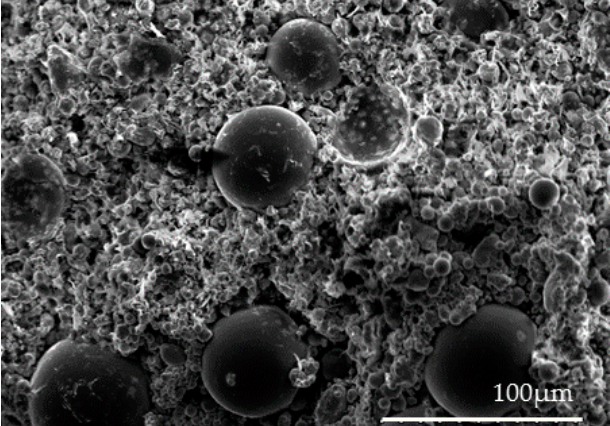
Figure 2. Scanning electron microscope photograph of powder, binder, and polymethyl methacrylate (PMMA) space holder (50 μ m) mixture.